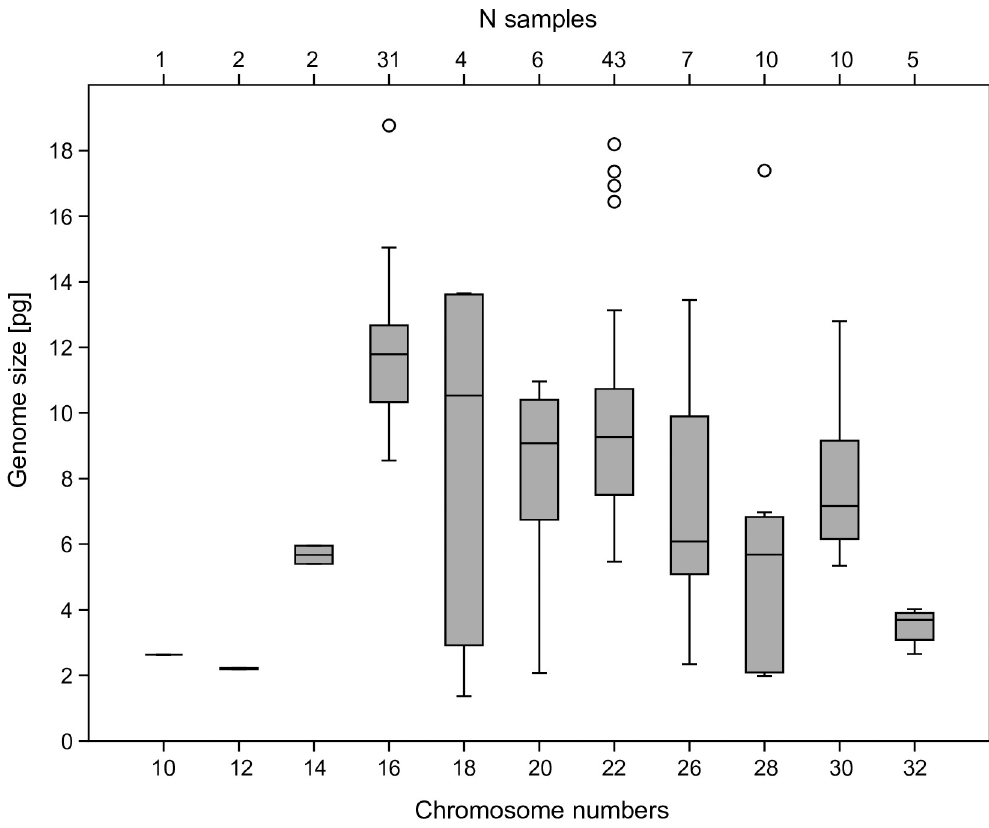
Fig 1. Box plot of number of chromosomes (2n+X0) in male Orthoptera vs. genome size (1C